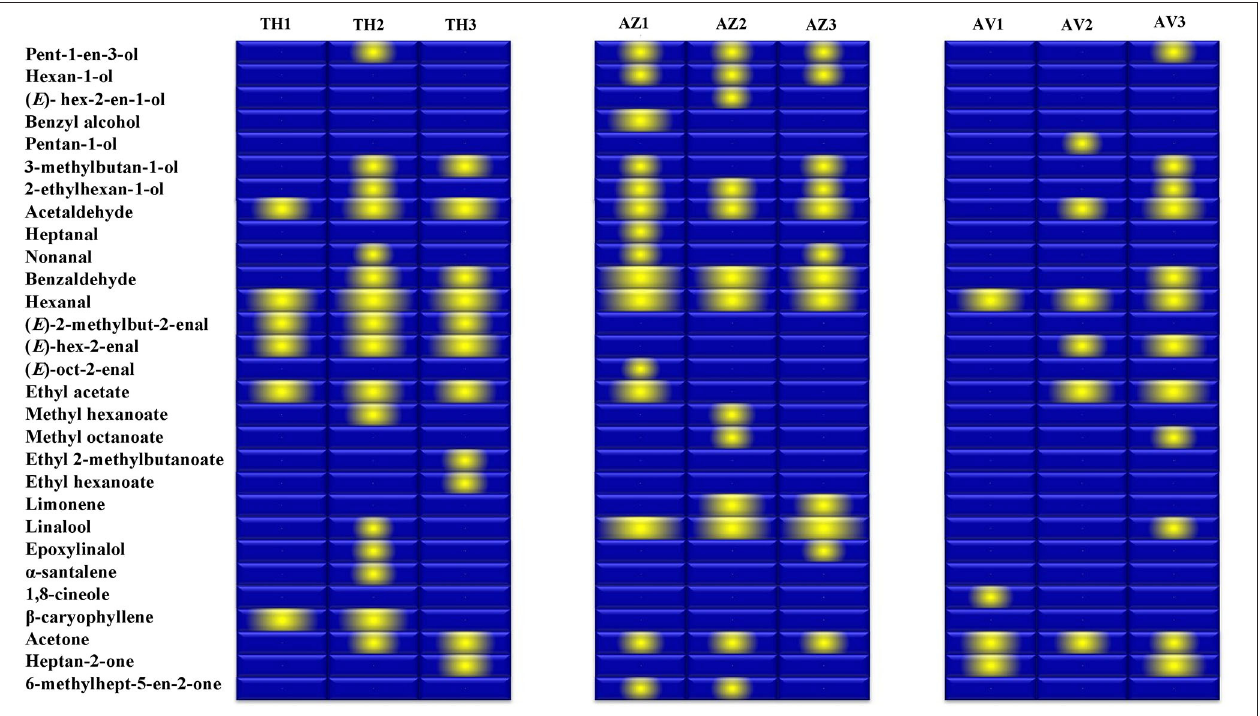
FIGURE 5 | Gallery plot of VOC expression intensity of TH (Taamriwthe), AZ (Azegzaw), and AV (Averkane) figs during ripening stages. 1, unripe figs; 2, ripe figs; 3, fully ripe